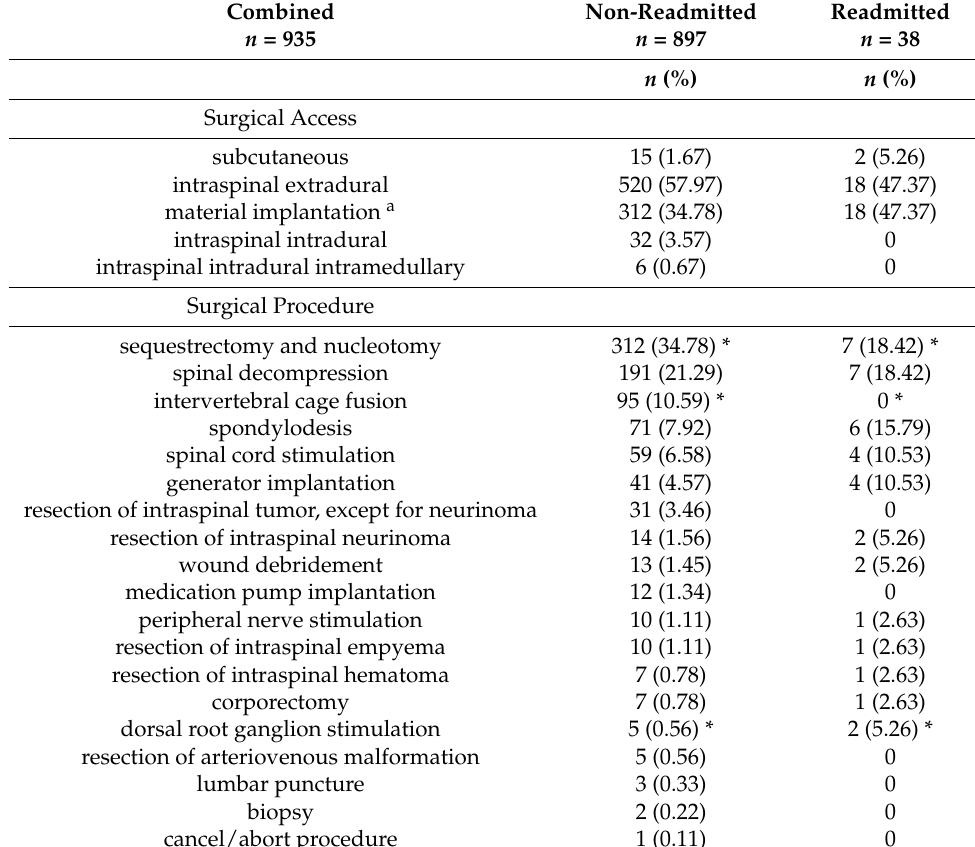
Table 4. Synopsis of surgical access and procedures comparing the readmitted and the non-readmitted population. Number, frequency, and p -value determined by Fisher exact